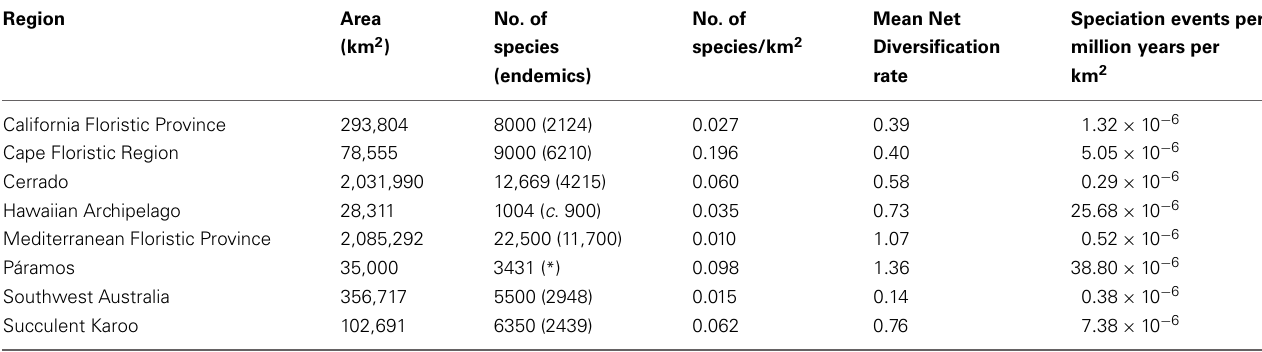
Table 2 | Biodiversity Hotspots species richness and mean net diversification rates.